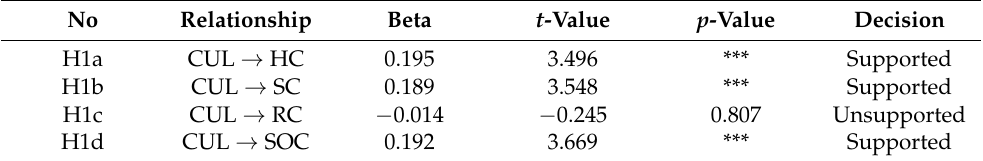
Figure 3. Assessment of the structural equation modelling. Note: CUL = culture; TRU = trust; HC = human capital; SC = structural capital; RC = relational capital; SOC = social capital; IP = innovation performance. Table 5. Relationship between culture and intellectual capital.